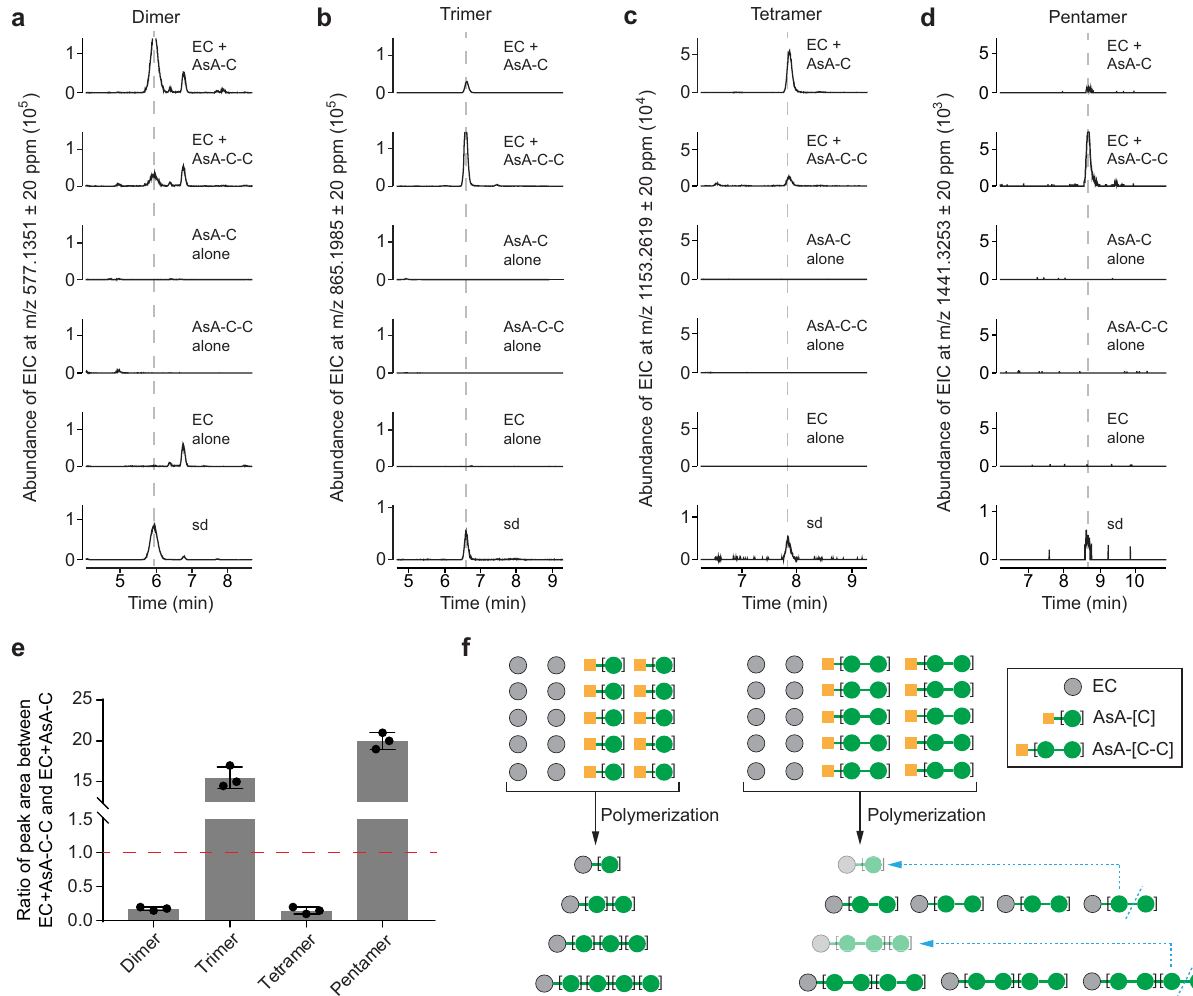
Fig. 8 In vitro non-enzymatic polymerization of ( − )-epicatechin (EC) with either AsA-C or AsA-C-C. a Detection of PA dimer formation (EIC at m/z 577.1351± 20 ppm). b Detection of PA trimer formation (EIC at m/z 865.1985 ± 20 ppm). c Detection of PA tetramer formation (EIC at m/z 1153.2619 ± 20 ppm). d Detection of PA pentamer formation (EIC at m/z 1441.3253± 20 ppm). e The ratio of the peak areas of the different PAs between the EC + AsA- C-C and EC + AsA-C reaction groups. Data are shown as the mean ± SD (for n = 3 independent replicates, paired comparisons between two reaction groups). f A model of AsA-C and AsA-C-C participating in PA polymerization as extension units. During PA oligomerization, AsA-C acts as the monomeric extension unit by sequentially adding a single building block, while AsA-C-C acts as the dimeric extension unit by sequentially adding two building blocks at once. Blue dashed lines with arrows indicate that PA by-products with even number degree of polymerization (DP) in EC + AsA-C-C are possibly sourced from the depolymerization of PAs with odd number DP. Source data of Fig. 8e are provided as a Source Data fi